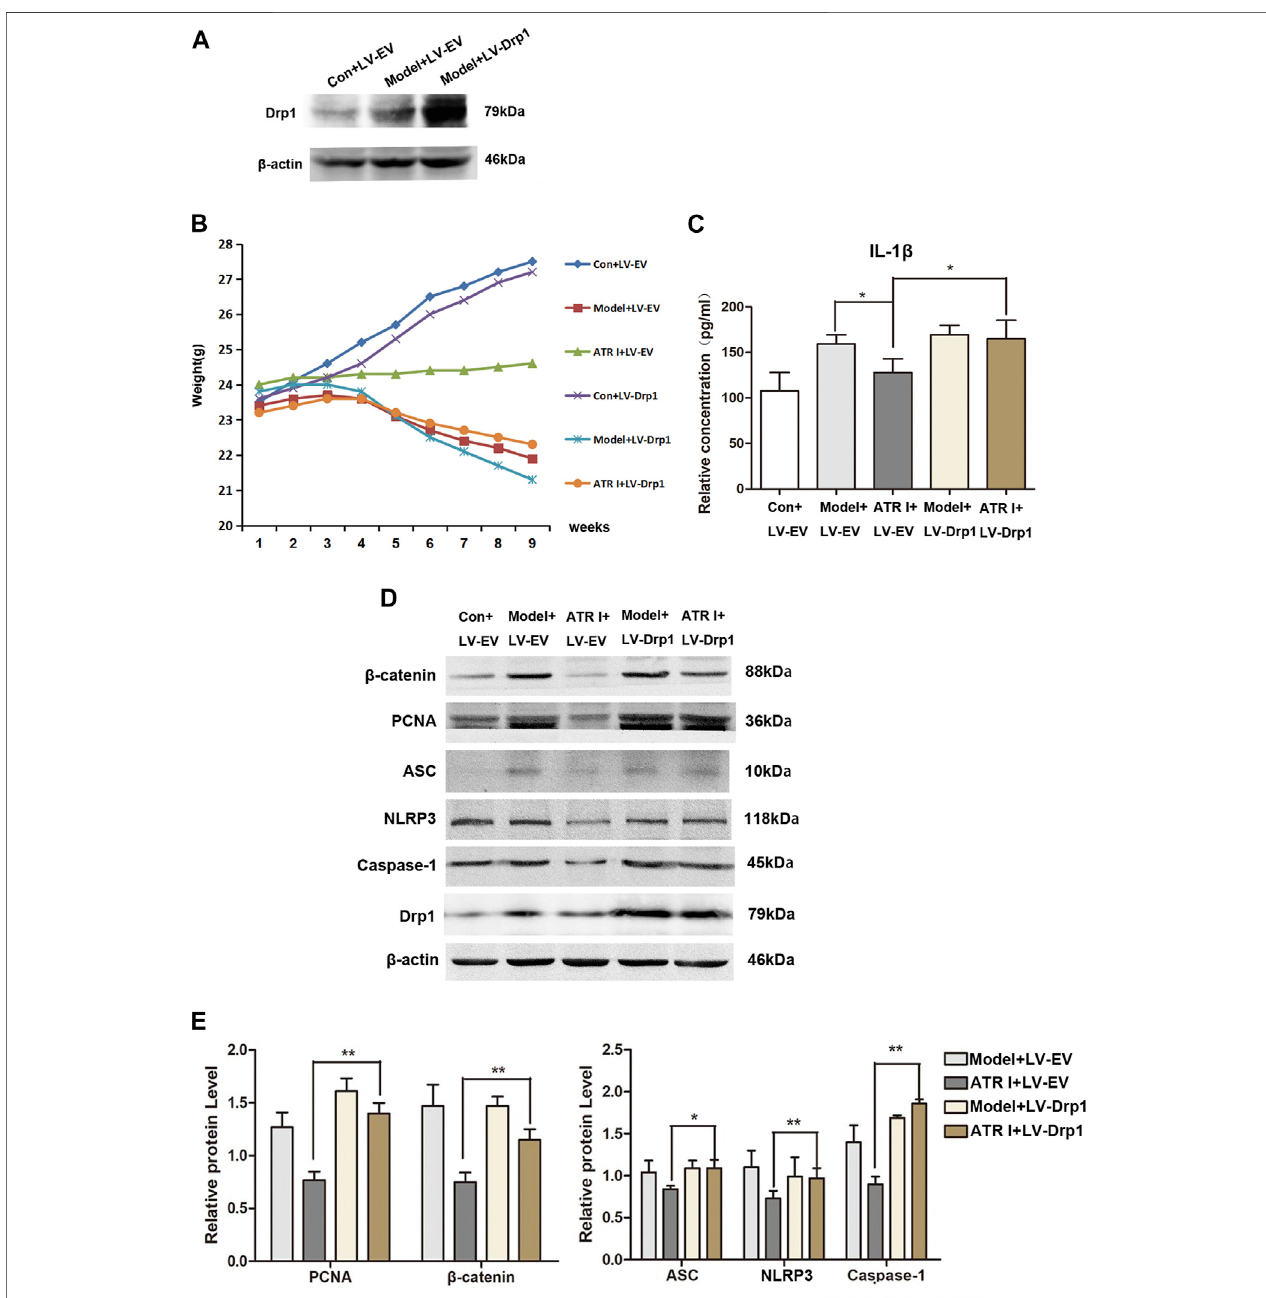
FIGURE 6 | Upregulation of Drp1 reverses the effect of atractylenolide I on NLRP3 in fl ammasome activation. (A) Drp1 lentivirus (LV-Drp1) expression vector transductionincreasedtheexpression ofDrp1comparedtothatofemptyvector(EV)transduction. (B) EffectofatractylenolideIonbodyweightofmicetransfected with the Drp1 lentivirus vector or empty vector (Model + LV-Drp1: 22.92 ± 1.05 vs ATR I + LV-Drp1: 23.04 ± 0.47, p -value 0.7584). (C) The concentrations of IL-1 β in the serum of mice were measured by ELISA. (D,E) Expression levels of NLRP3, caspase-1, ASC, β -catenin, and PCNA in the intestinal tract were detected by the Western blot analysis (n (cid:2) 3 per group). The densitometric analysis bar diagram of the results: * p < 0.05; ** p < 0.01, vs. model (mean ± S.D).